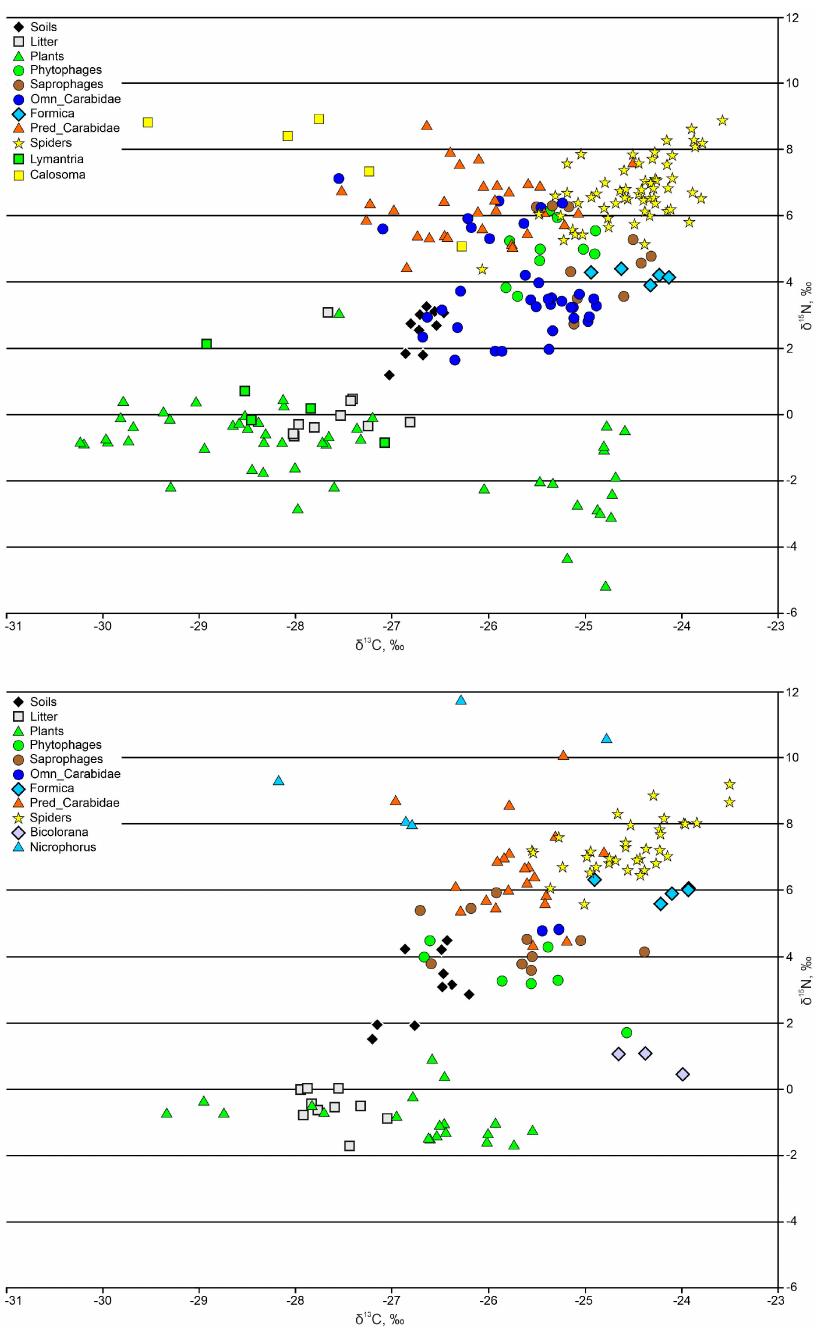
Figure 5. Isotopic composition ( δ 13 C and δ 15 N values) of soil, plants, litter, and main trophic and taxonomic groups of arthropods in the forest (above) and steppe (below) ecosystems. Each symbol represents one specimen. Omn_Carabidae: omnivorous Carabidae ( Amara and Harpalus ), Pred_Carabidae: predaceous Carabidae (other